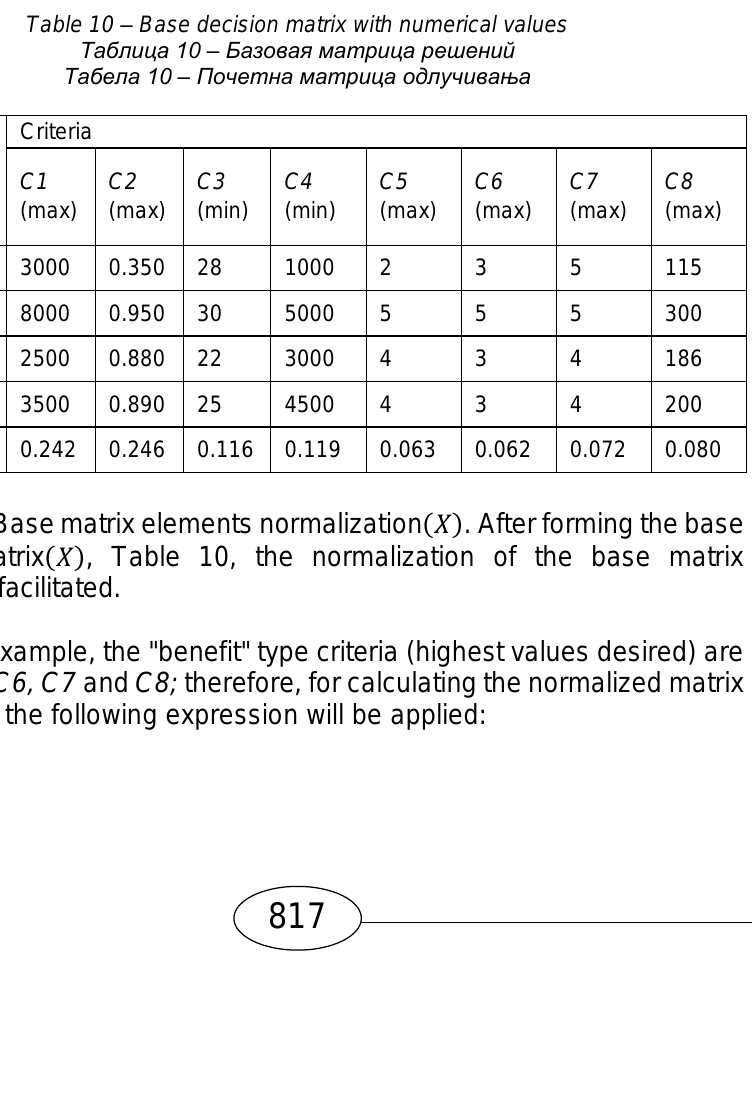
Table 10 – Base decision matrix with numerical